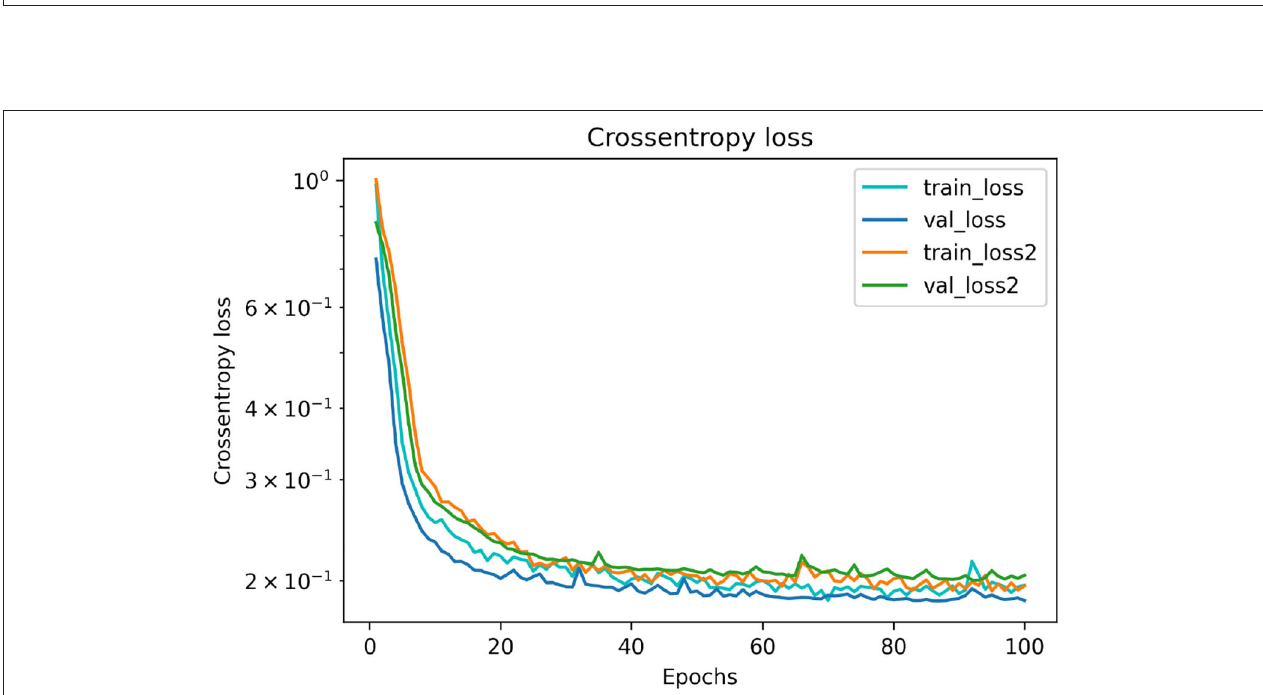
FIGURE A1 | The training and validation accuracy curves of Q-CNN02-DS-OP , in cyan and blue, respectively. The best model was found at epoch 88. The training and validation accuracy curves obtained using bootstrapping are overlaid in orange and green, respectively, with the best model found at epoch 92. This comparison further demonstrates that the uncertainty on the accuracy of the network is relatively low.